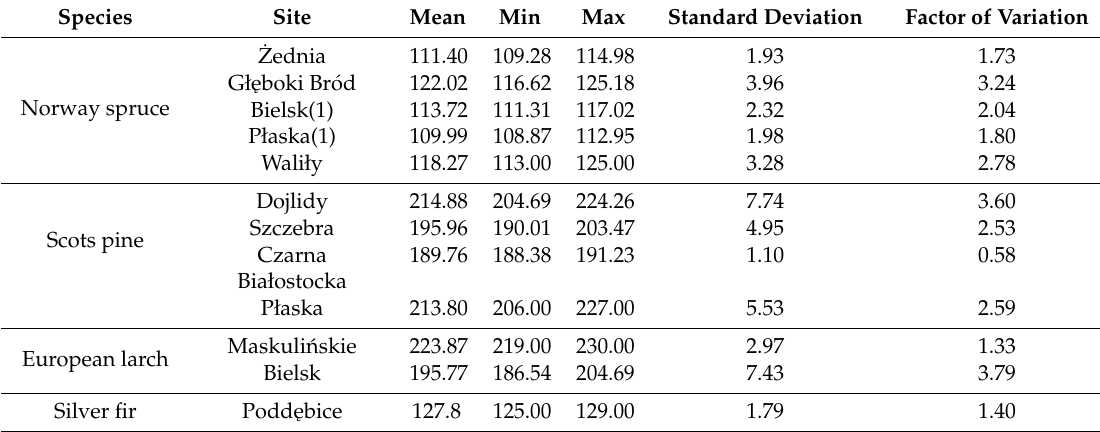
Species Site Mean Max Standard Deviation Factor of Variation